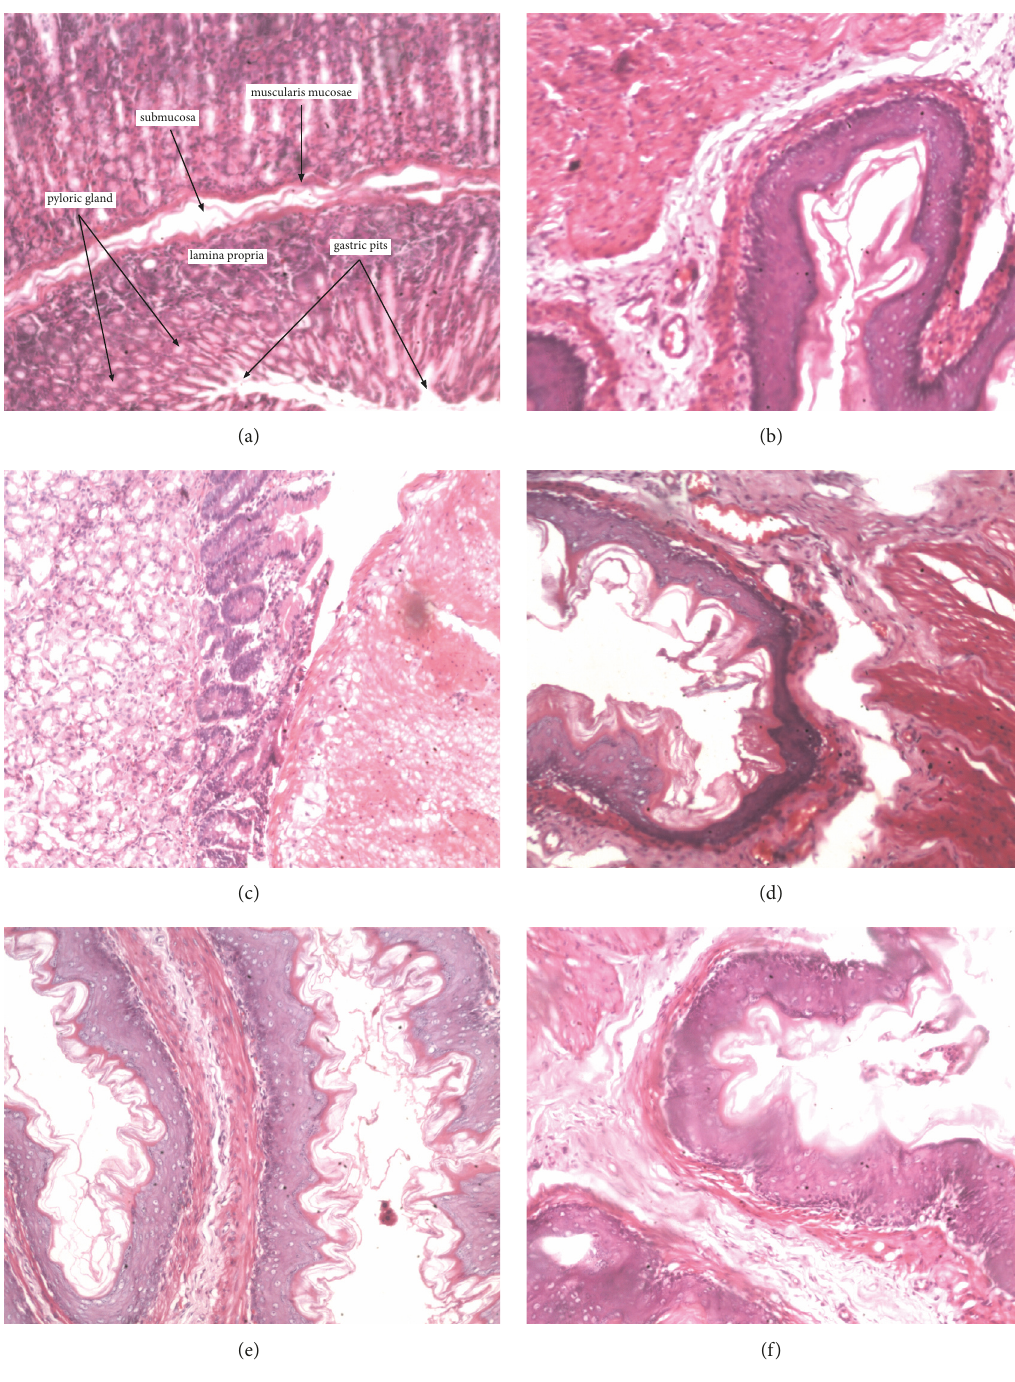
Figure 6: Photomicrograph of the sections of the stomach in control rats (a) and rats treated orally with 30 mg kg −1 (b), 100mg kg −1